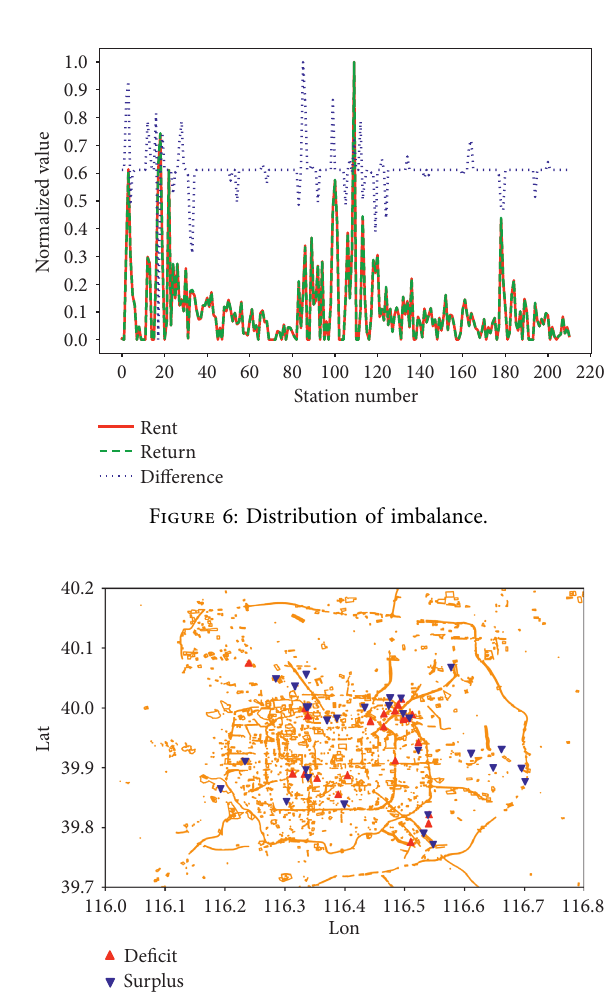
Figure 5: The proportion of stations leaving and arriving at a station.